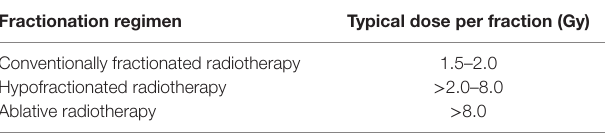
TABLe 1 | various daily fractionation